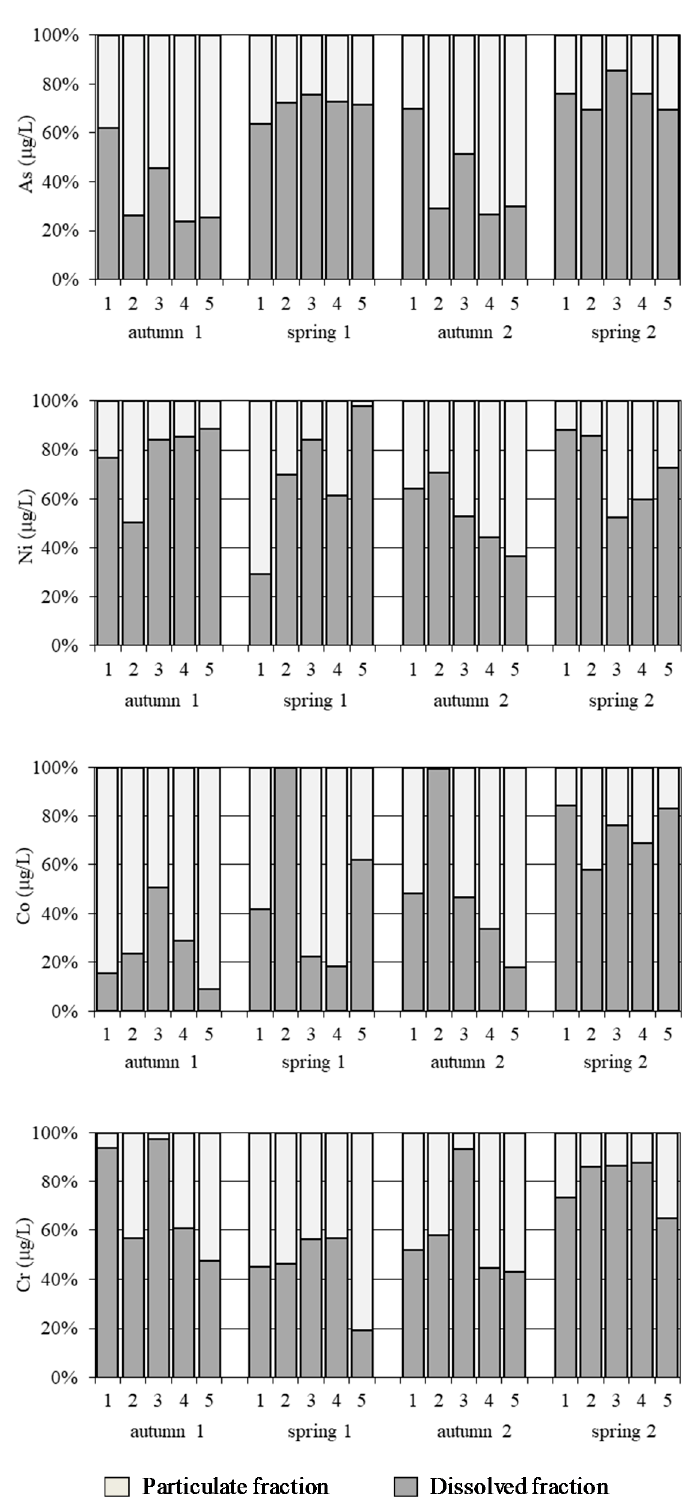
Figure 5. As, Ni, Co and Cr total concentrations and distribution of dissolved and particulate fractions in water samples at the 5 sites of Algeciras Bay.